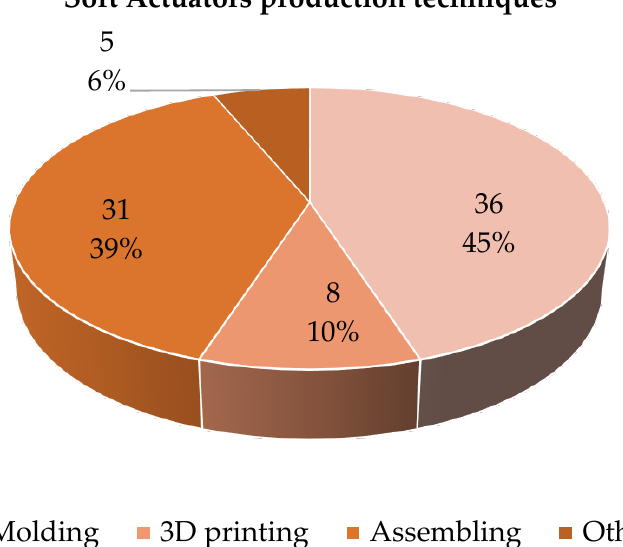
Figure 31. Comparison of distribution of the production techniques of soft pneumatic